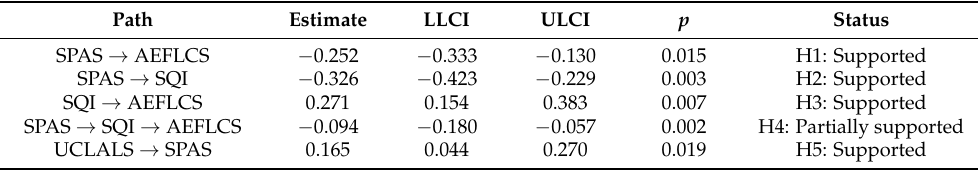
Table 3. Hypotheses testing.